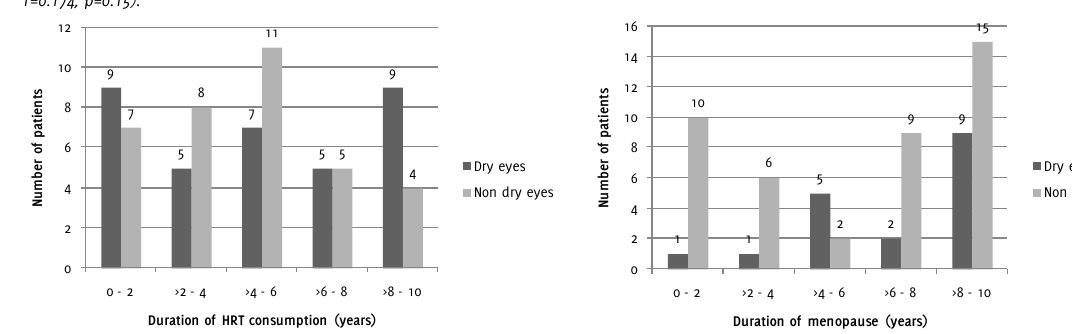
Figure 2. Relationship between duration of HRT consumption and dry eyes. There was no significant association between the occurrence of dry eyes and duration of HRT consumption. (r value = -0.133 and